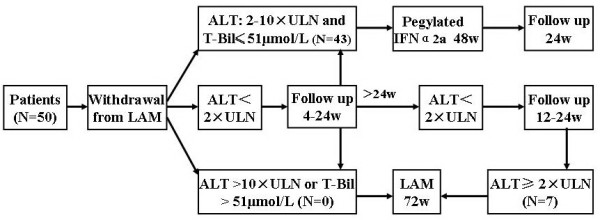
Study design. Liver function was tested 4-weekly within 24 weeks of lamivudine withdrawal and 12-weekly after 24 weeks of lamivudine withdrawal. ALT: alanine aminotransferase; ULN: upper limit of normal; IFN: interferon; T-Bil: total bilirubin; LAM: lamivudine.